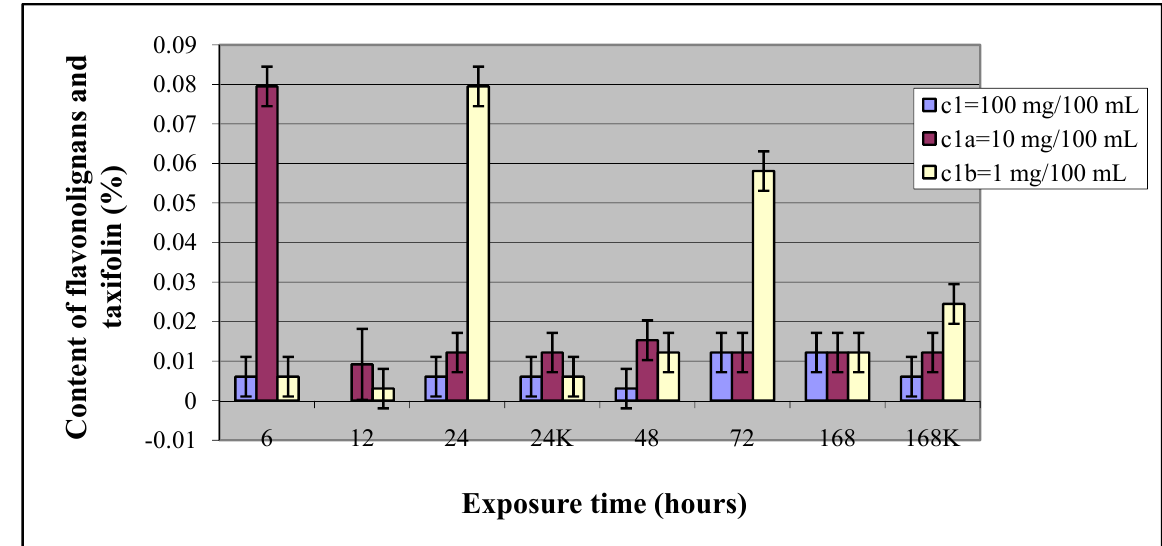
Figure 2. Dependence of the content of flavonolignans and taxifolin in callus culture Silybum marianum related to the elicitor exposure times compared between treatments with three different concentrations of compound 1 and between controls.